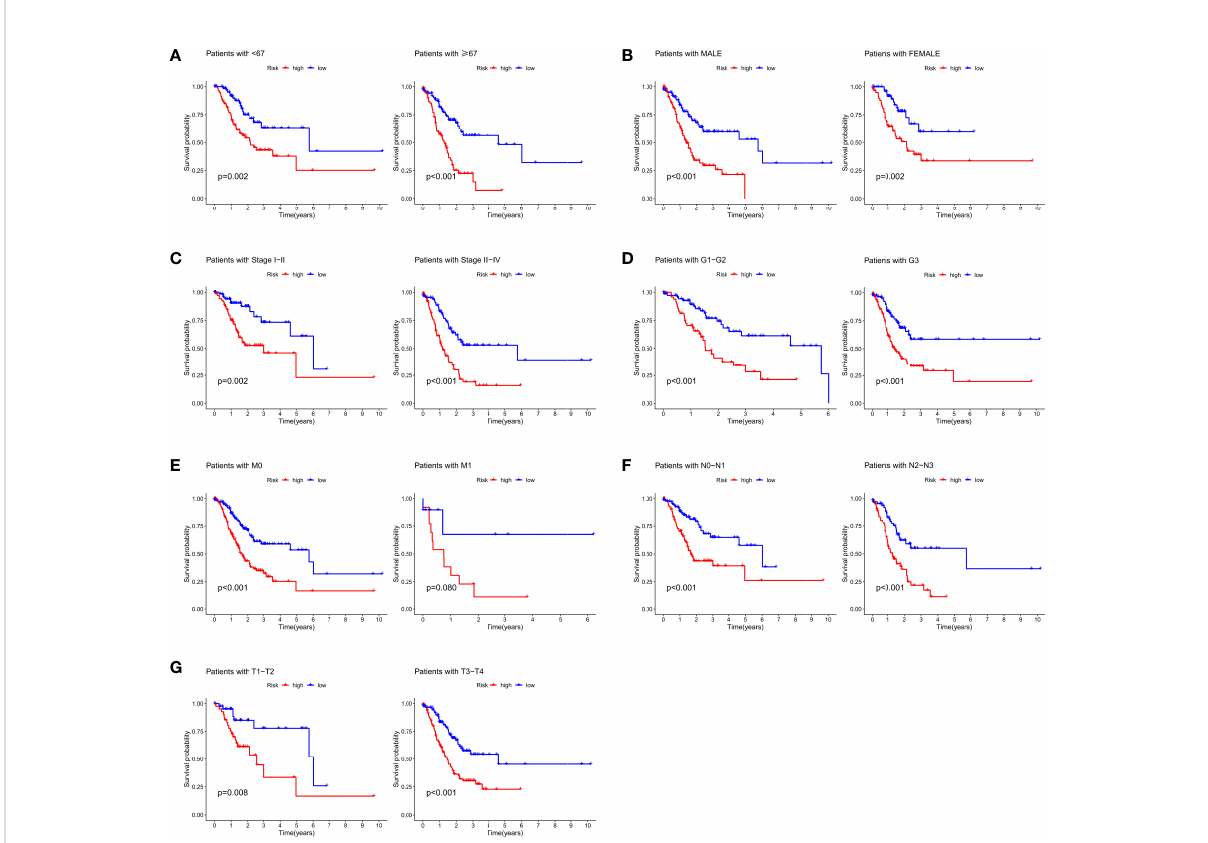
FIGURE 3 K-M survival analysis for clinicopathological subgroups divided by age (A) , sex (B) , clinical stage (C) , histological grade (D) , M (E) , N (F) , and T (G)